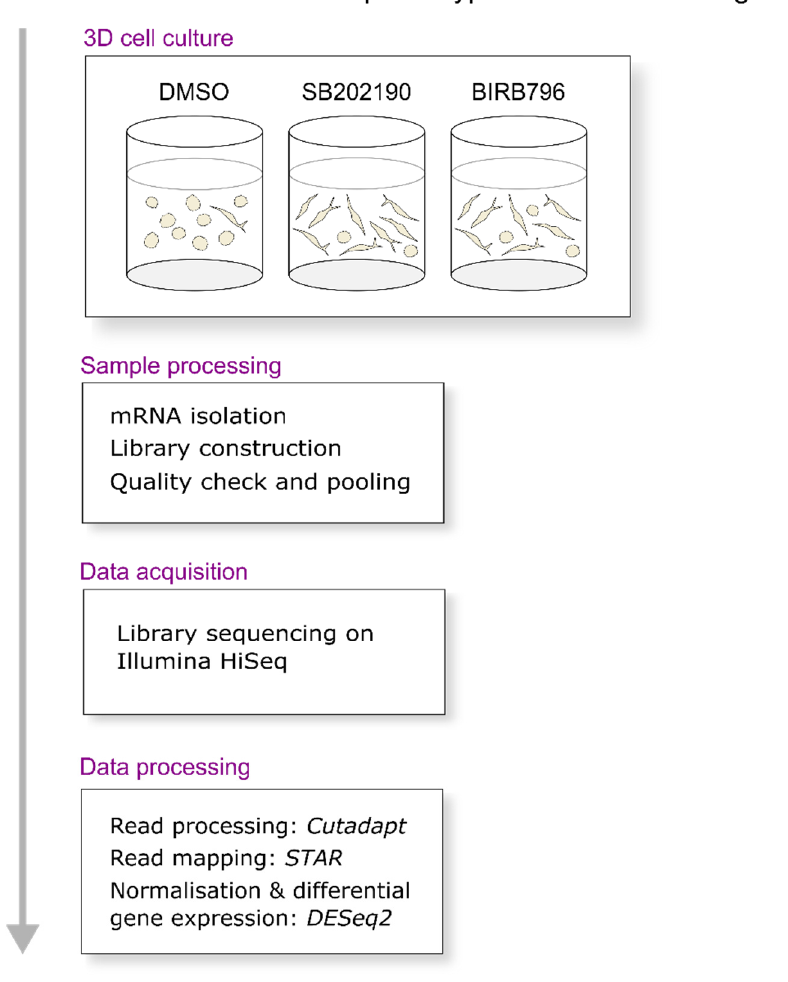
Figure 3. Data acquisition and processing strategy. The sequencing yielded approx. 21–26.5 million paired-end reads per sample. Raw reads trimmed from adapter sequences were quality checked with FastQC software [69]. FastQC’s plots of Phred scores by position showed typical profiles with decreasing quality towards the ends of reads (Figure 4A).